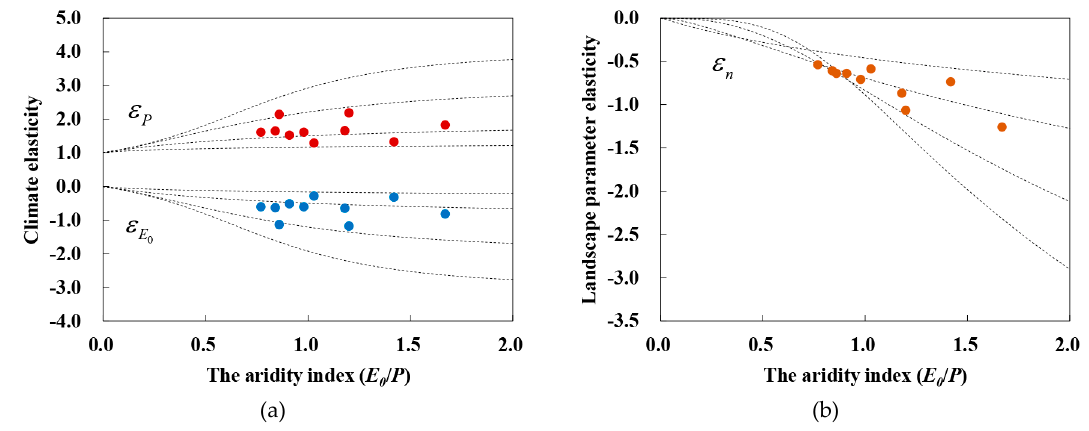
Figure 3. Relationship between the elasticity (( a ) ε P and ε E ; ( b ) ε n ) of runo ff and the aridity index ( E 0 / P ). Note: the line represents the elasticity of runo ff ; a red dot represents ε P , a blue dot represents ε E 0 , and an orange dot represents for the 10 regions.